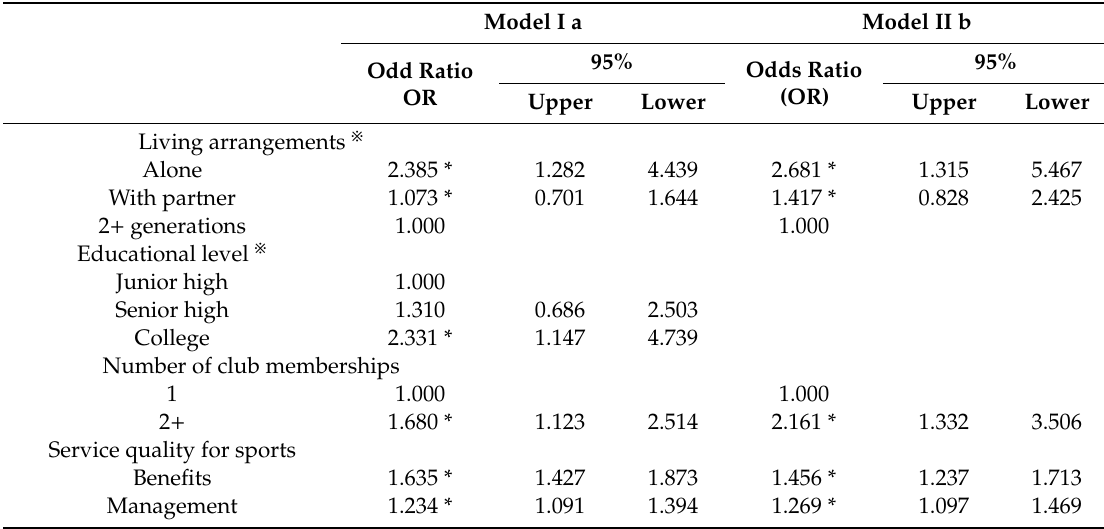
Table 2. Multiple logistic regression model for factors associated with healthy active aging.